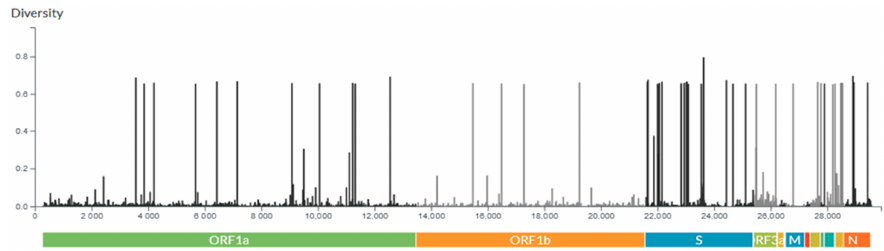
Figure 7. Entropy of genome information (high-resolution image can be found in supplementary material).